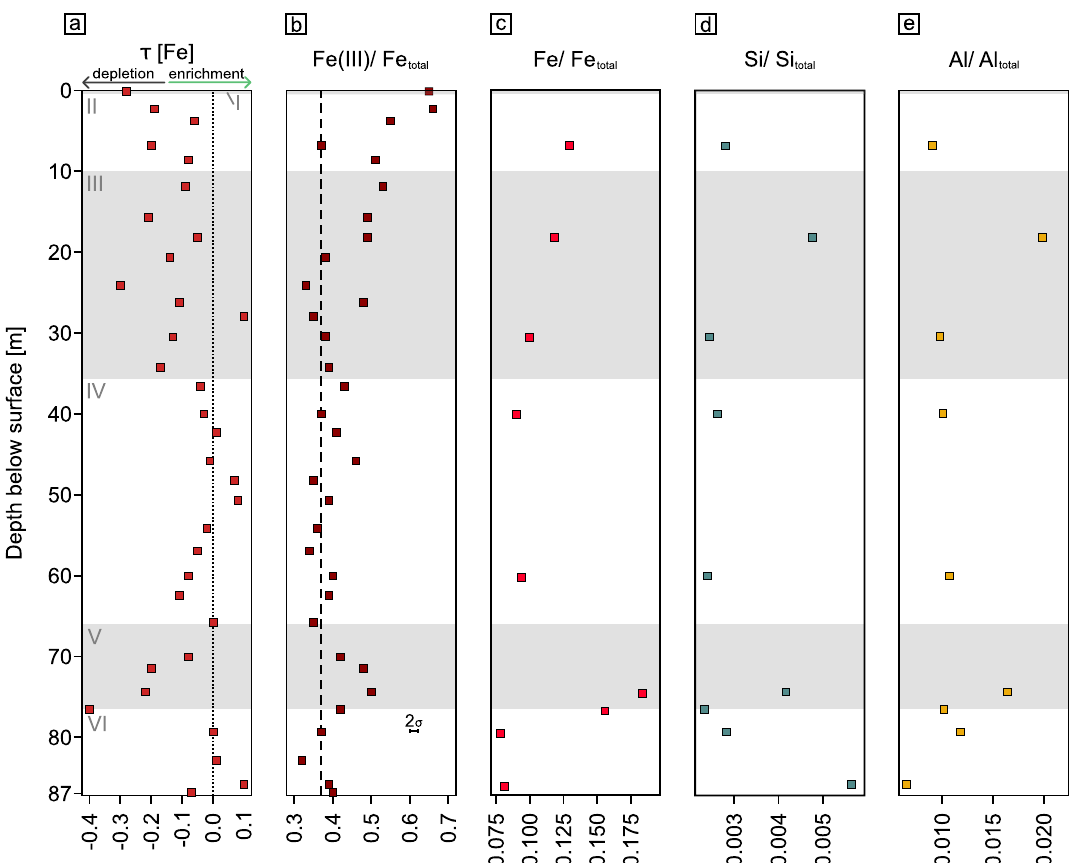
Figure 7. Weathering degree characterization by using Fe, Si, and Al. ( a ) Elemental mass transfer coefficient (τ) of Fe, dotted line indicates zero loss. Values < 0 show relative depletion of Fe, values > 0 enrichment of Fe relative to bedrock. ( b ) Redox state of bulk drill core samples, here shown as Fe(III)/Fe total ratios. Dashed line indicates the average bedrock value of 0.37. ( c ) Ratio of reactive Fe mineral fraction (extractable by citrate bicarbonate dithionite, (CBD)) to total Fe content here expressed as Fe/Fe total . ( d ) Si/Si total ratios representing ratio of CBD extractable Si to total Si. ( e ) Al/Al total ratios representing ratio of CBD extractable Al to total Al. Grey and white shades denote the different zones (I–VI) described in the